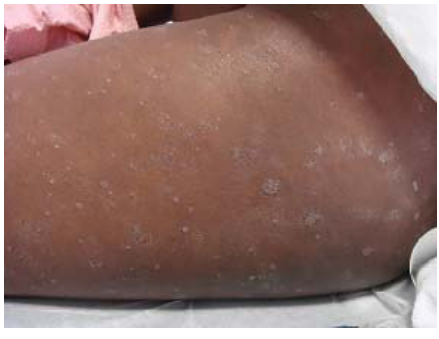
Figure 8. Psoriasis-eczema overlap.